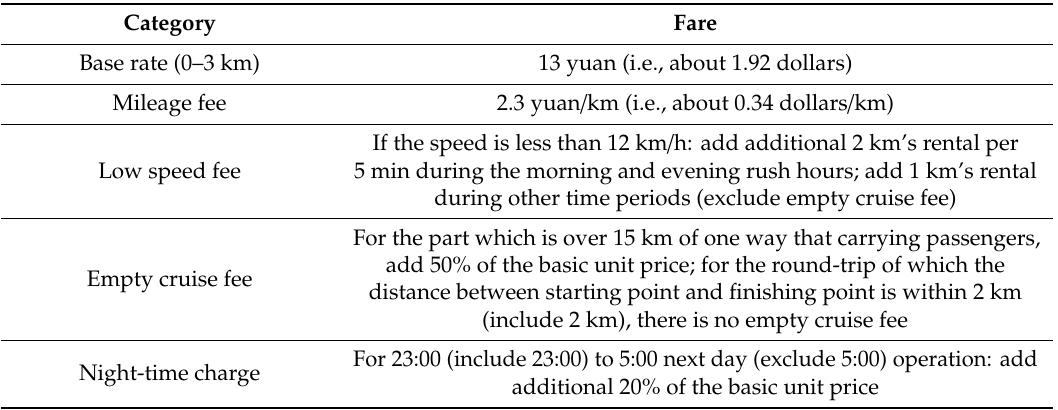
Table 4. Charge standard of taxi in Beijing.